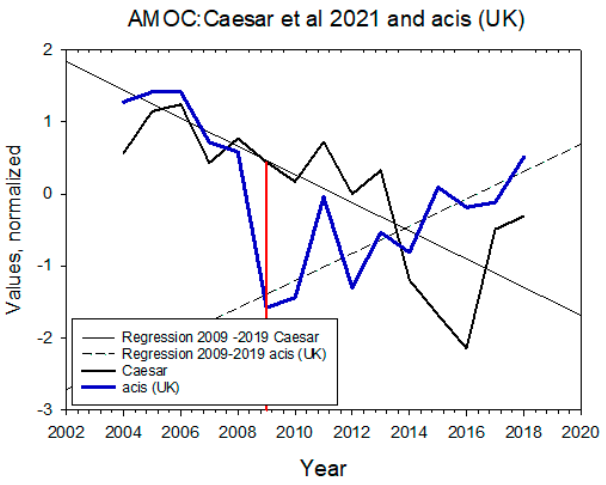
Figure A1. AMOC time series. The regression lines (straight lines) show regressions from 2009 to 2019; that is, the last decade. The Caesar, McCarthy [6] time series (black line) are annual averages. The blue line shows cross-year average values from March one year to April next year, and with the Ekman (wind-driven) component removed. The Acis (UK) values are read from a graph. The Caesar data were kindly supplied by Levke Caesar, Maynooth